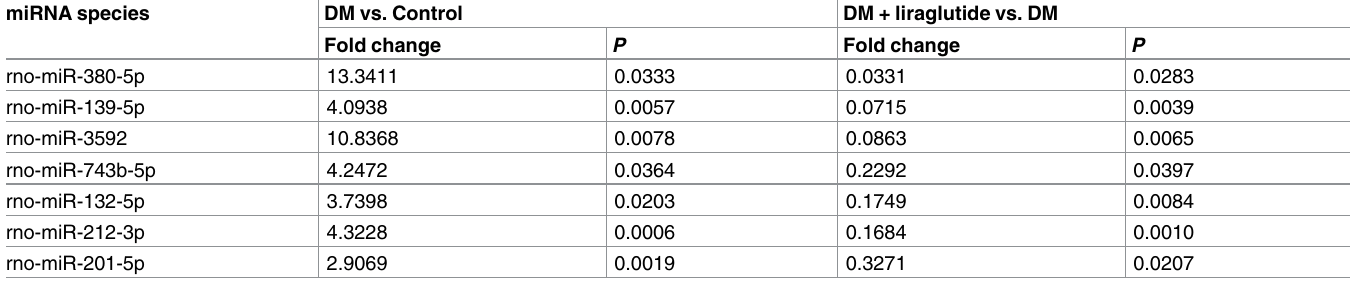
Table 1. Differential expression of miRNAs in rat pancreatic tissues between the three groups (DM group, control group, and DM + liraglutide group). miRNA species DM vs. Control DM + liraglutide vs. DM Fold change P Fold change P